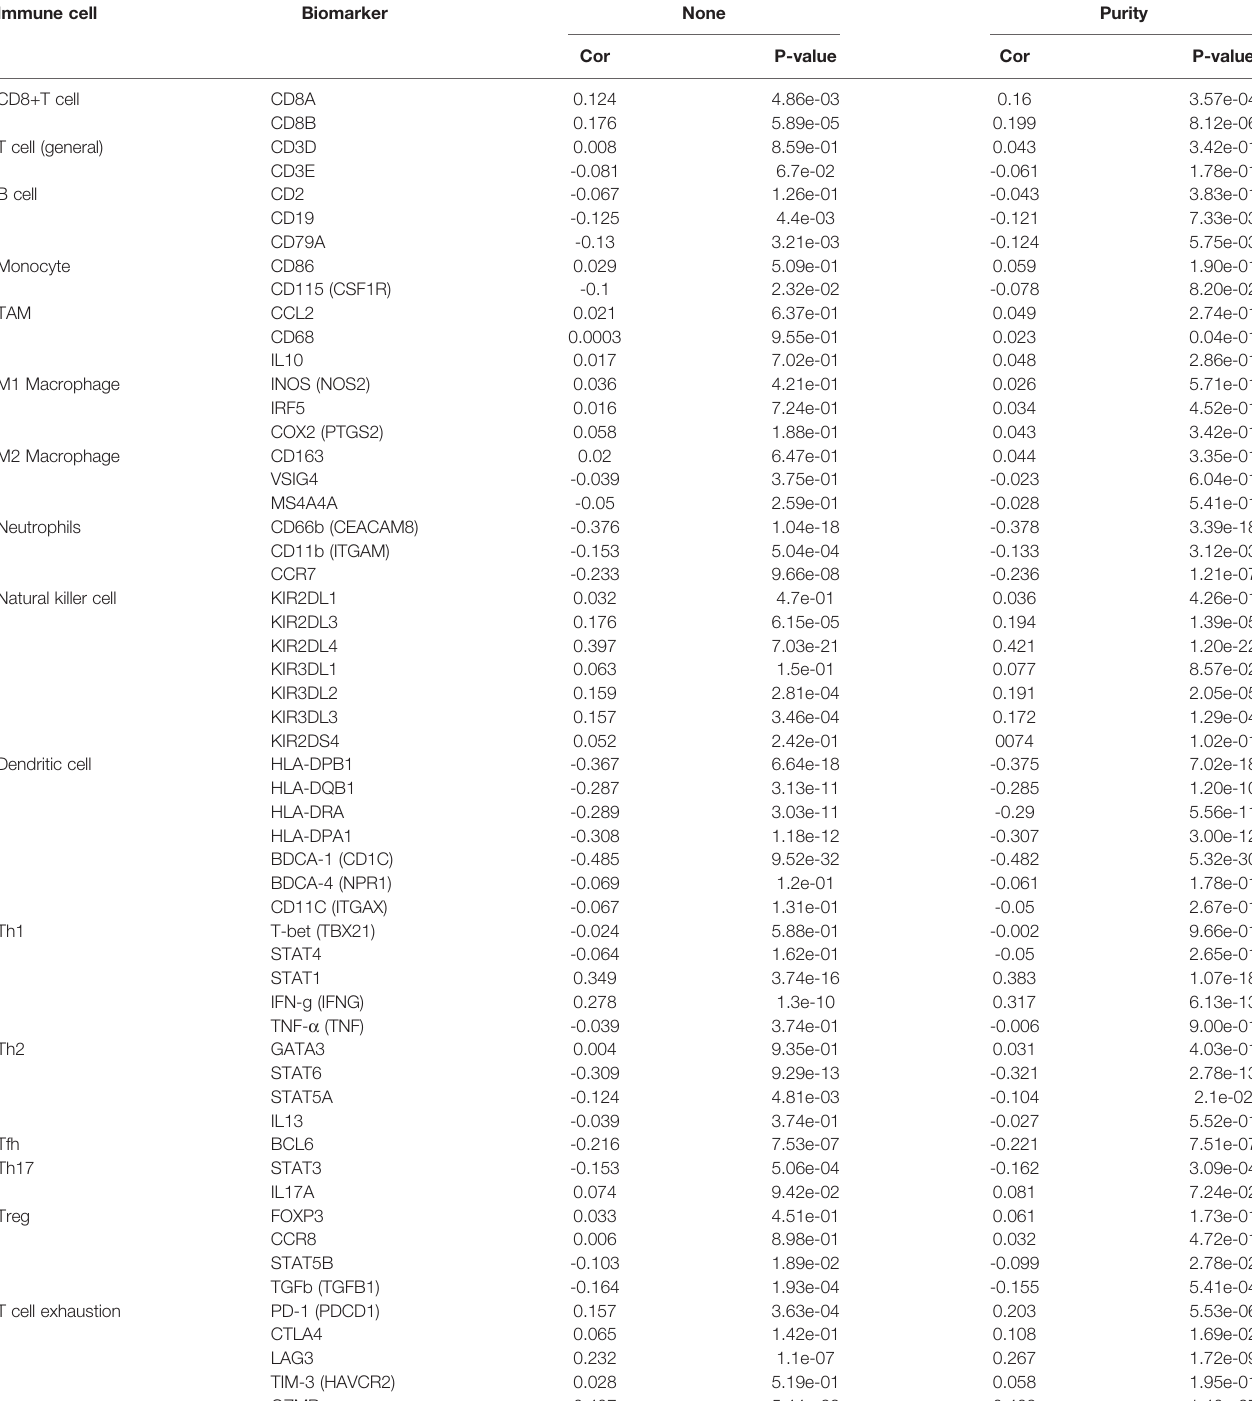
TABLE 1 | Correlation analysis between BIRC5 and gene biomarkers of immune cells in LUAD (TIMER). Immune cell Biomarker None Purity Cor P-value Cor P-value CD8+T